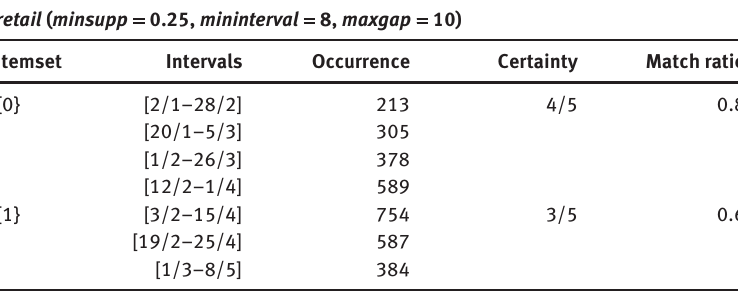
Table 6. Selected Yearly Periodic Itemsets of Size One (for retail ).